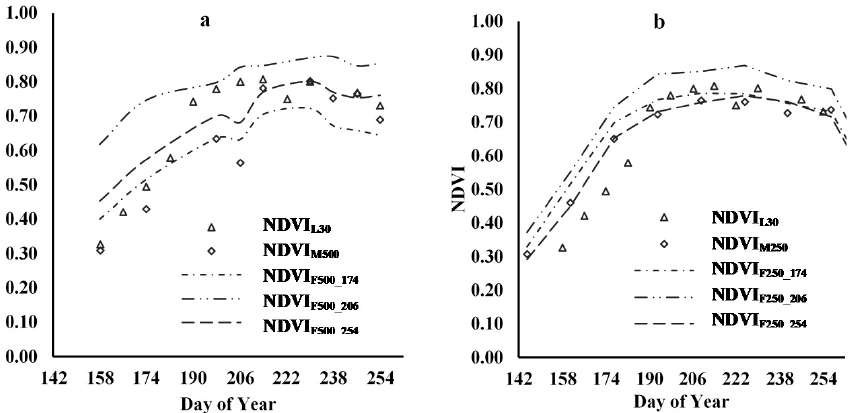
Figure 14. Time-series data of NDVI from Landsat, MODIS, and different fusion products for plot A ( a ) 500 m MOD09GA; ( b ) 250 m MOD13Q1.